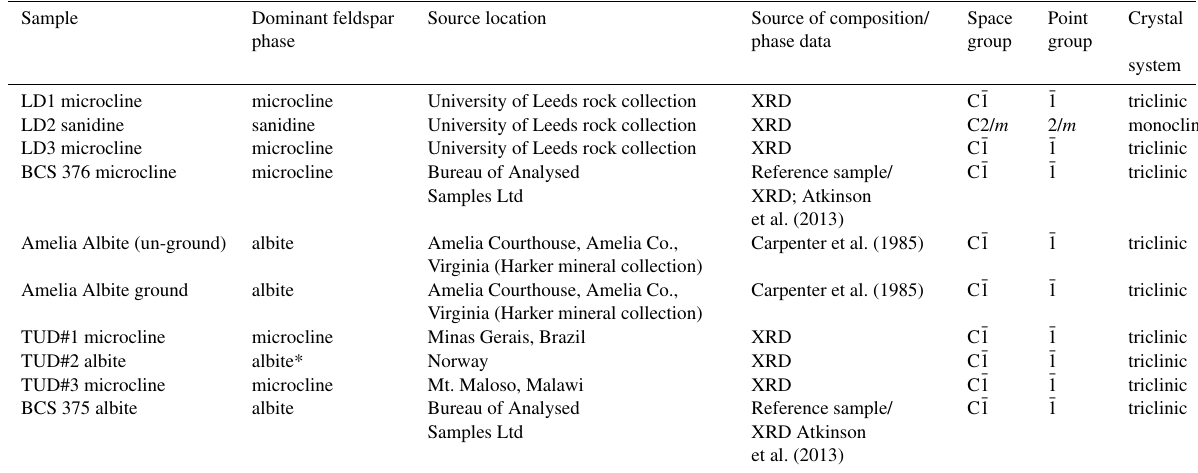
Table 2. Alkali feldspars used in this